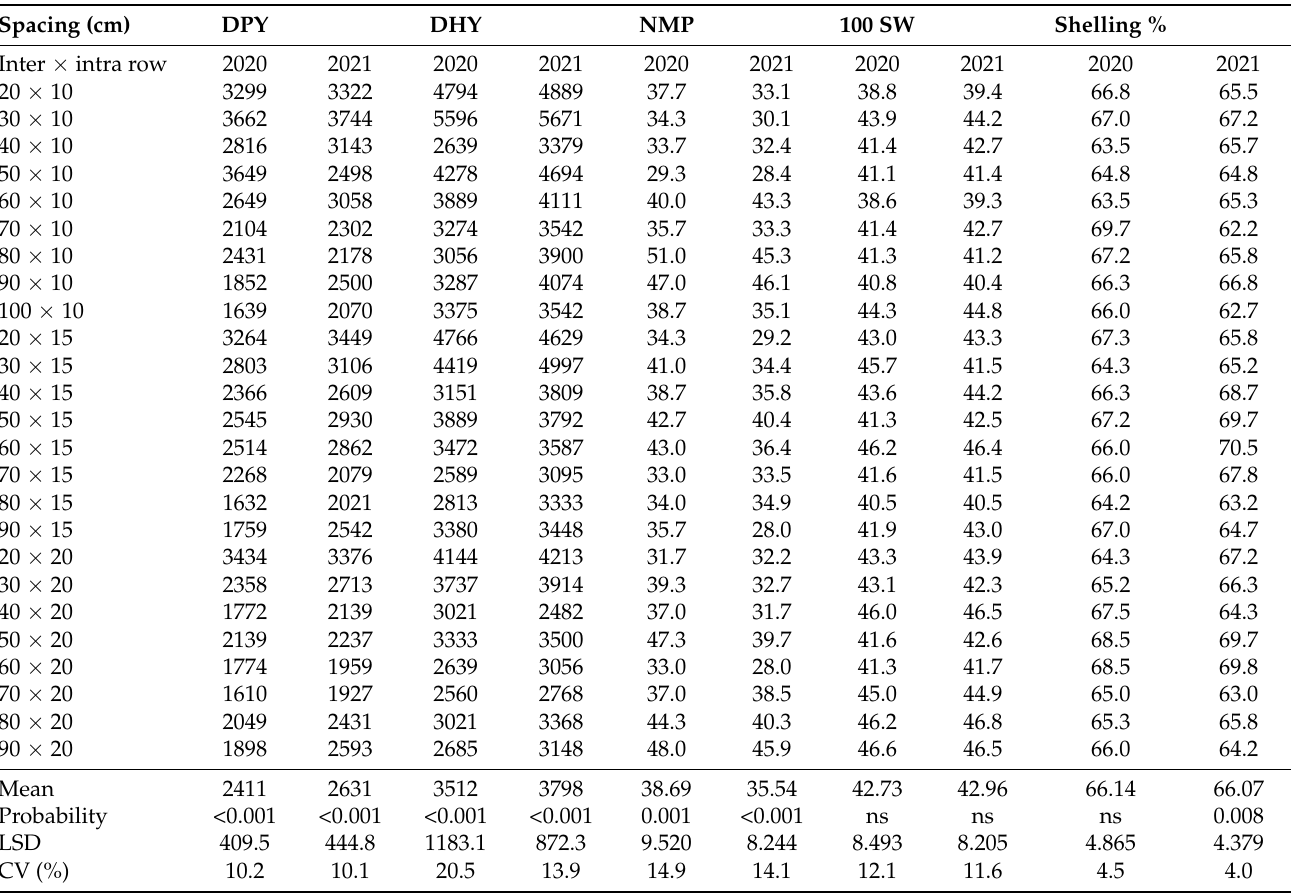
Table 4. Mean performance of spacing treatments for DPY, DHY, NMP, 100 SW, and shelling % during the dry season in 2020 and 2021.